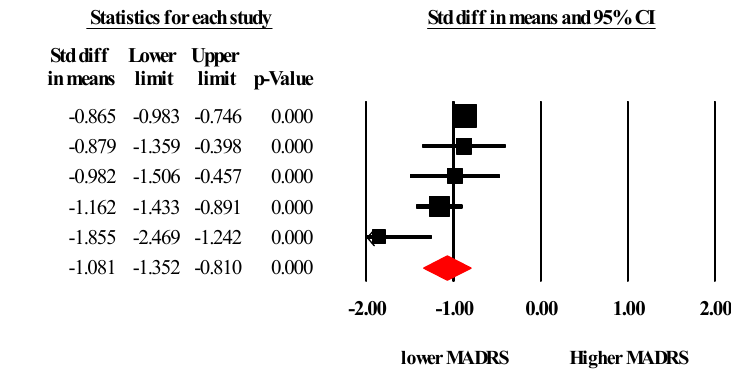
Figure 3. Forest plot of the Montgomery–Åsberg Depression Rating Scale (MADRS) across the